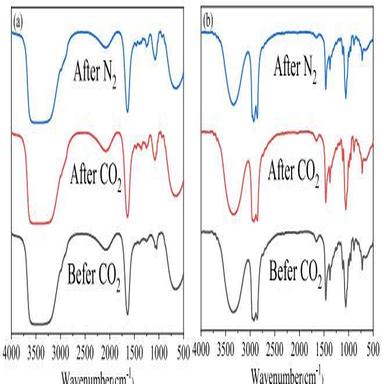
FT-IR spectrum of CO2-responsive phase transfer materials (PEG-200) in the process of phase transfer. (a Aqueous phase; b organic phase.)